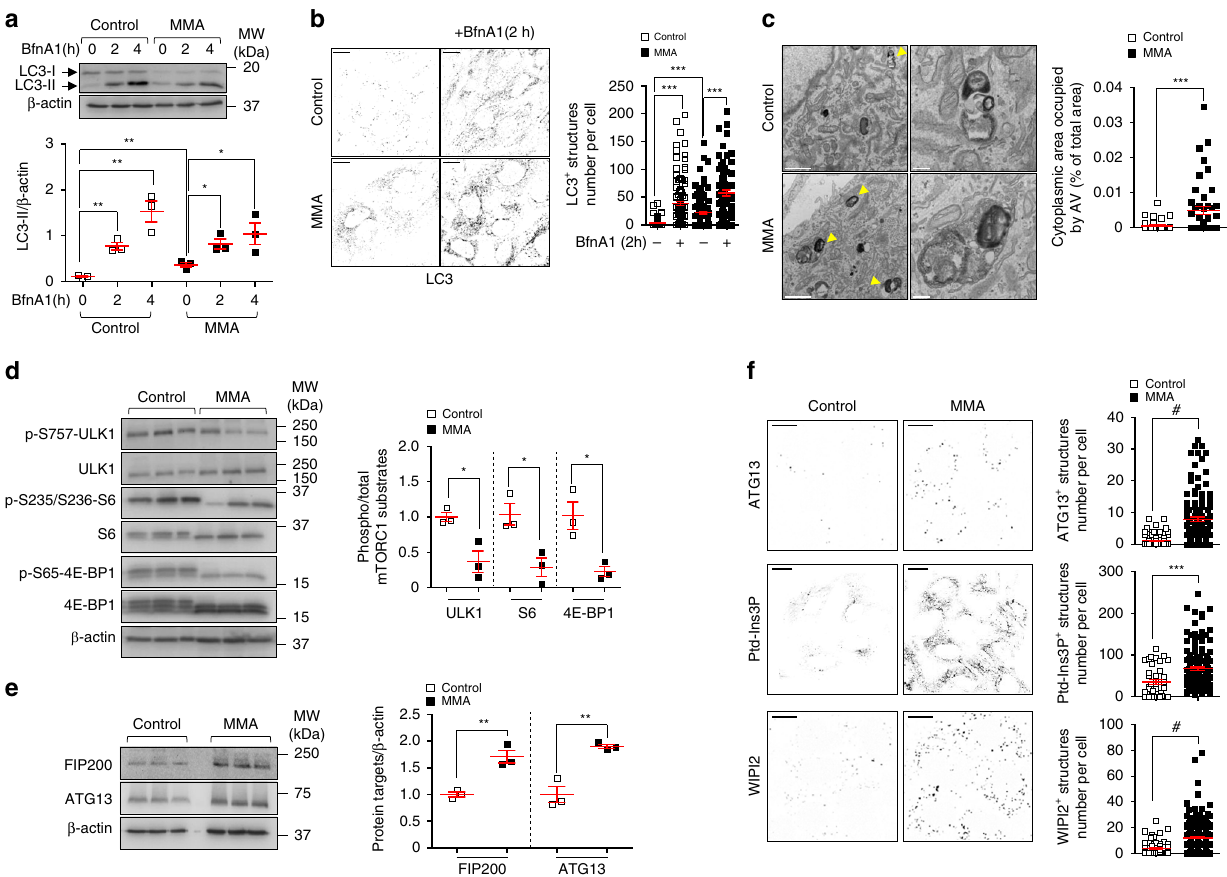
Fig. 4 MMUT de fi ciency stimulates autophagy in MMA kidney cells. a , b Cultured cells were exposed to lysosome-based proteolysis inhibitor Ba fi lomycin A1 (BfnA1, 250nM for the indicated times). Representative immunoblotting and quanti fi cation of LC3-II; n = 3 biologically independent experiments. Two- tailed Student ’ s t -test, * P < 0.05 and ** P < 0.01 relative to untreated control or MMA cells. b Representative inverted images and quanti fi cation of numbers of punctate LC3 + structures per cell; n = 122 untreated control cells, n = 127 BfnA1-treated control cells, n = 127 untreated MMA cells and n = 77 BfnA1- treated MMA cells. Values are pooled from three biologically independent experiments. One-way ANOVA followed by Bonferroni ’ s post hoc test, *** P < 0.001 relative to untreated control or MMA cells. c Representative electron micrographs and quanti fi cation of cytoplasm area occupied by autophagy vacuoles (AV; expressed as the percentage of the total area); n = 43 control cells and n = 45 MMA cells pooled from two biologically independent experiments. Arrowheads indicate EM-compatible AV. d , e Immunoblotting and quanti fi cation of ( d ) phosphorylated and total forms of mTORC1 substrates and of ( e ) FIP200 and ATG13, n = 3 biologically independent experiments. f Representative inverted images and quanti fi cation of numbers of ATG13 + (top) or Ptd-Ins3P + (middle) or WIPI2 + (bottom) structures per cell, respectively. Number of ATG13 + structures: n = 86 control cells and n = 118 MMA cells. Number of Ptd-Ins3P + structures: n = 41 control cells and n = 141 MMA cells. Number of WIPI2 + structures: n = 71 control cells and n = 253 MMA cells. Values are pooled from three biologically independent experiments. Plots represent mean ± SEM. Two-tailed Student ’ s t -test, * P < 0.05, ** P < 0.01, *** P < 0.001 and # P < 0.0001 relative to control cells in c – f . β -actin was used as a loading control in a , d and e . Scale bars are 10 μ m in b and f , and 1 μ m and 250 nm in c (left and right panels, respectively). NS non-signi fi cant. Source data are provided as a Source Data fi